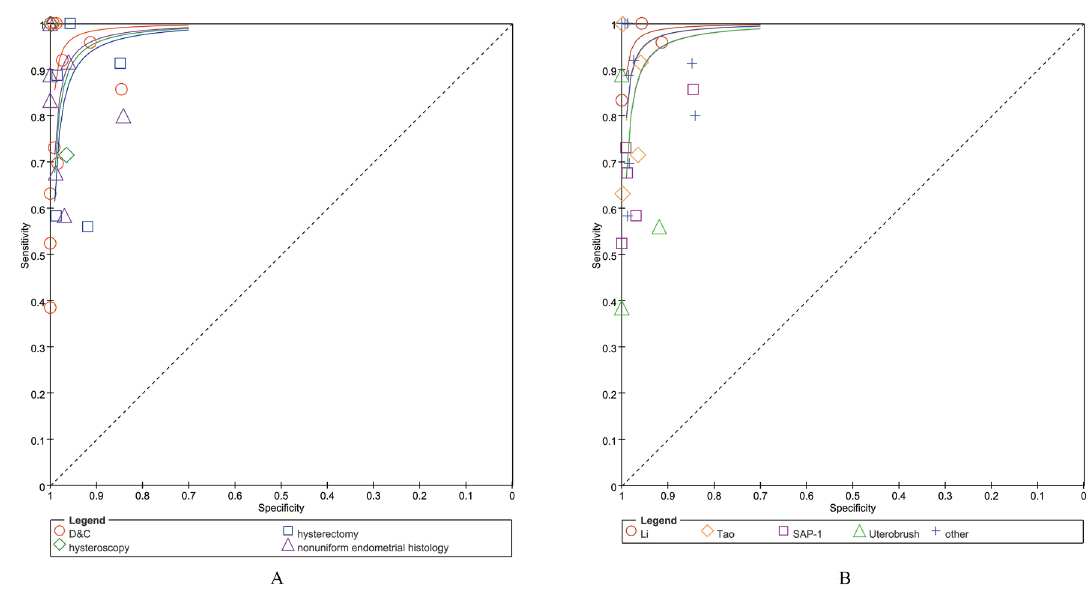
Figure 3. SROC (summary receiver operating curve) plot (( A ) with different reference standards; ( B ) with different cytologic sampling methods).